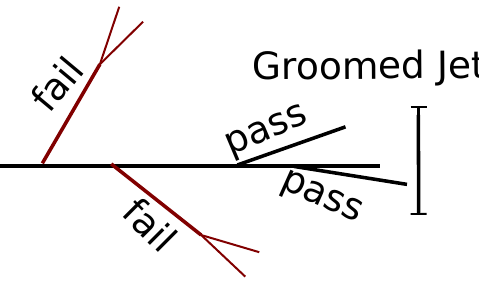
Figure 1 . Pictorial representation of the action of the mMDT on a candidate